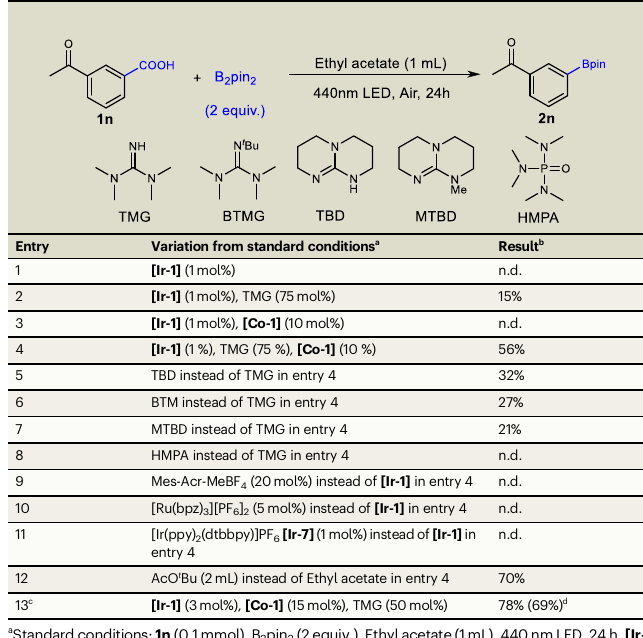
Table 1 | Optimization of Direct Decarboxylative Borylation